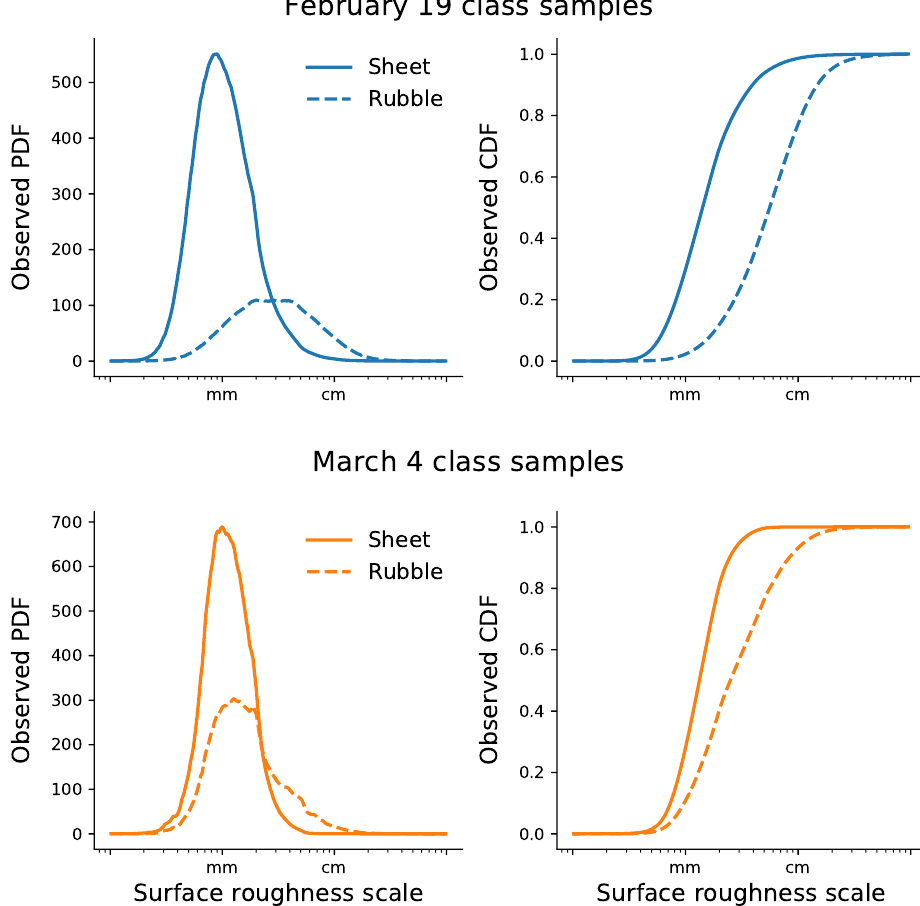
Figure 6. Observed probability density functions (PDF, left column ) and cumulative density func- tions (CDF, right column ) for UAV-derived river ice surface roughness measurements for visually- determined sheet ice and rubble ice class samples from the 19 February ( top row ) and 4 March ( bottom row ) aerial